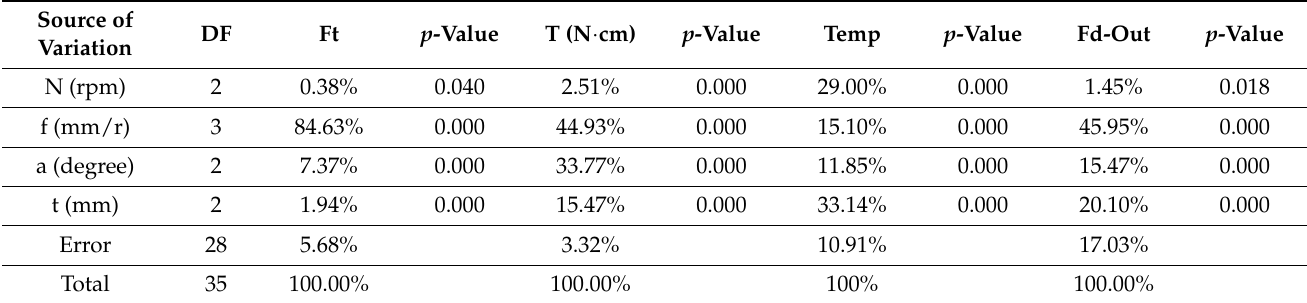
Table 9. ANOVA results with contribution of control factors effect on machinability responses.